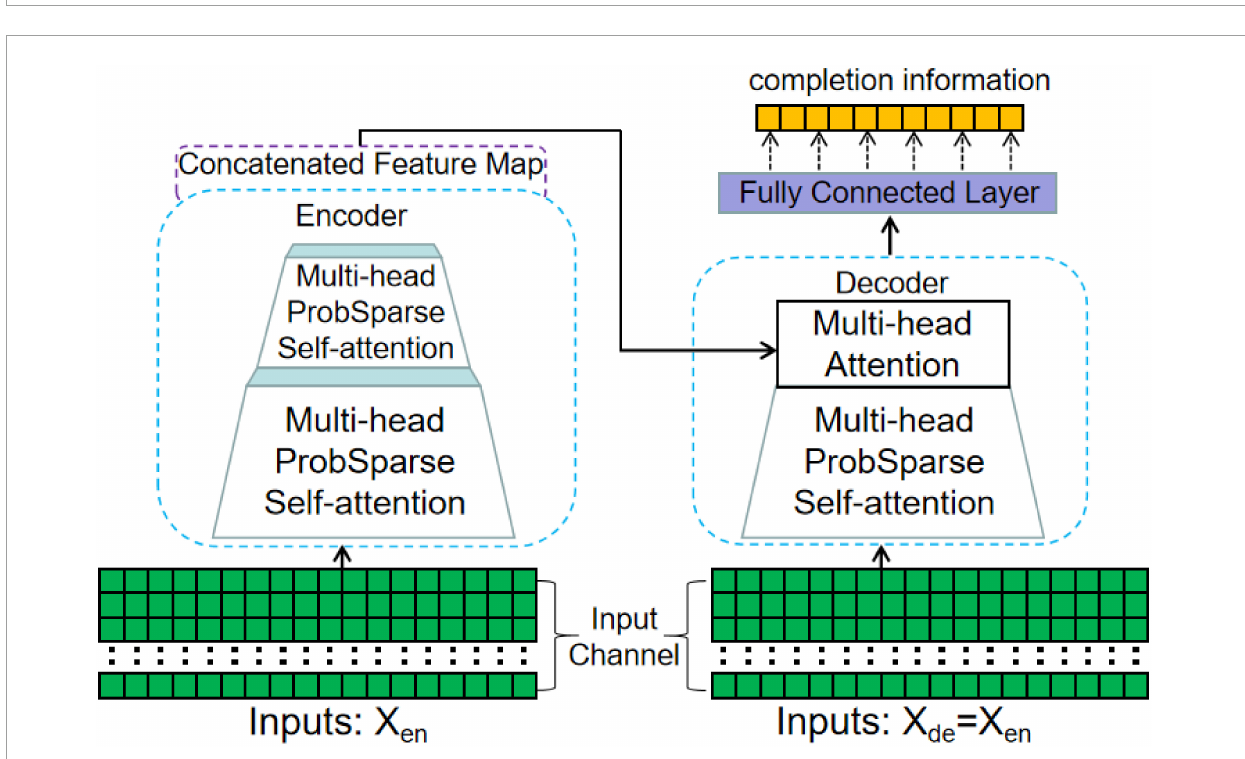
propagation during the inference phase, making it highly effective in time-series